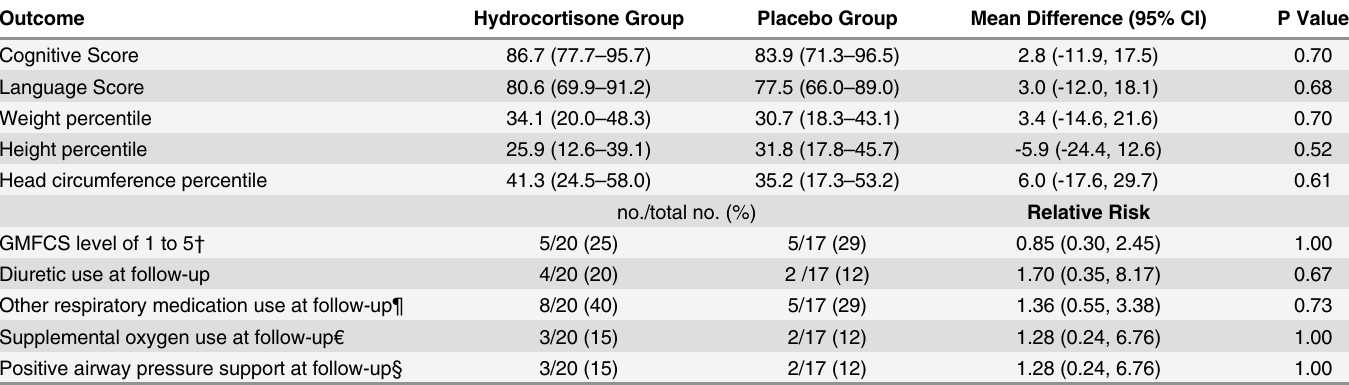
Table 3. Other Outcomes at 18 to 22 Months Corrected Age.